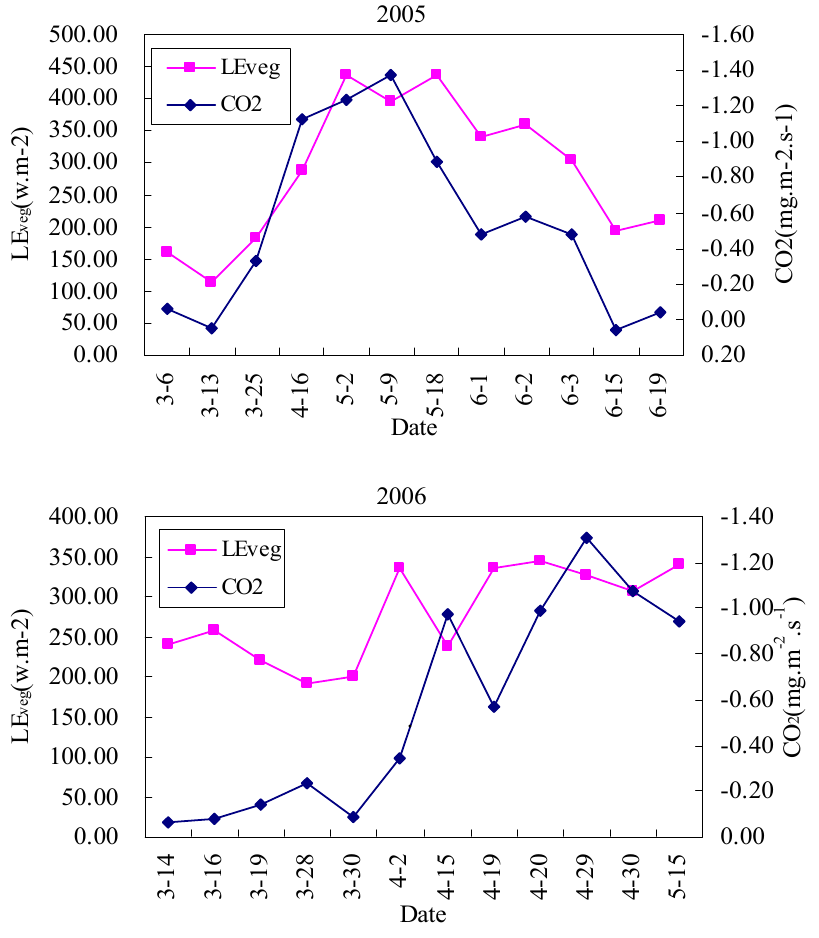
and measured CO flux during winter veg 2